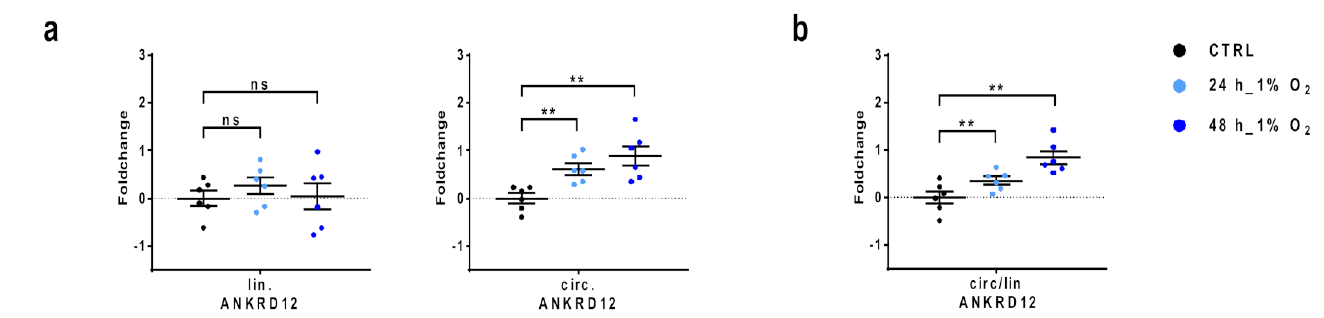
Figure 4. Induction of circular ANKRD12 in hypoxic HUVEC. HUVEC were exposed to 1% O 2 for 24 and 48 h or to normoxia for 24 h (CTRL). Expression levels of the circular and linear transcripts were measured by qPCR. ( a ) Scatterplot of the expression levels of circular (circ.) and linear (lin.) ANKRD12 transcripts in hypoxic HUVEC compared to CTRL. ( b ) Scatterplot of the circular-to- linear ratio (circ/lin) of ANKRD12 in hypoxic HUVEC compared to CTRL. Fold changes are in log2 scale ( − ∆∆ CT) and individual values are indicated by dots, while mean and SEM are indicated by horizontal lines ( n = 6; ** p < 0.01; ns: not significant).